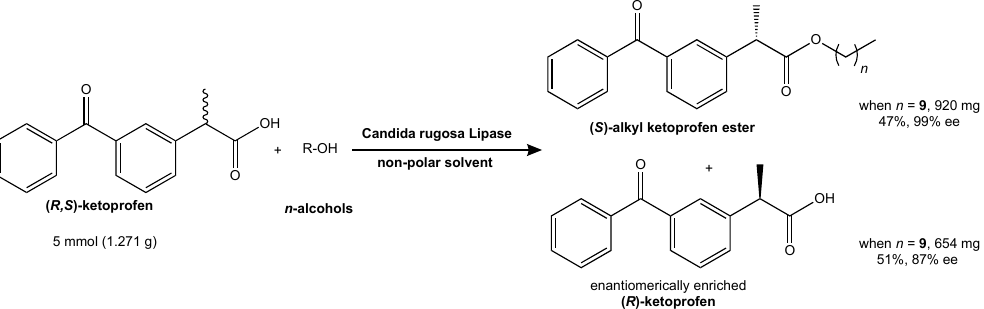
Figure 1. HPLC chromatograms; identification of ( S )-ketoprofen standard (right) tr = 12.67 min and racemic ketoprofen (left) with ( R )-ketoprofen tr = 9.55 min and ( S )-ketoprofen tr = 12.63 min. ( tr = time retention).